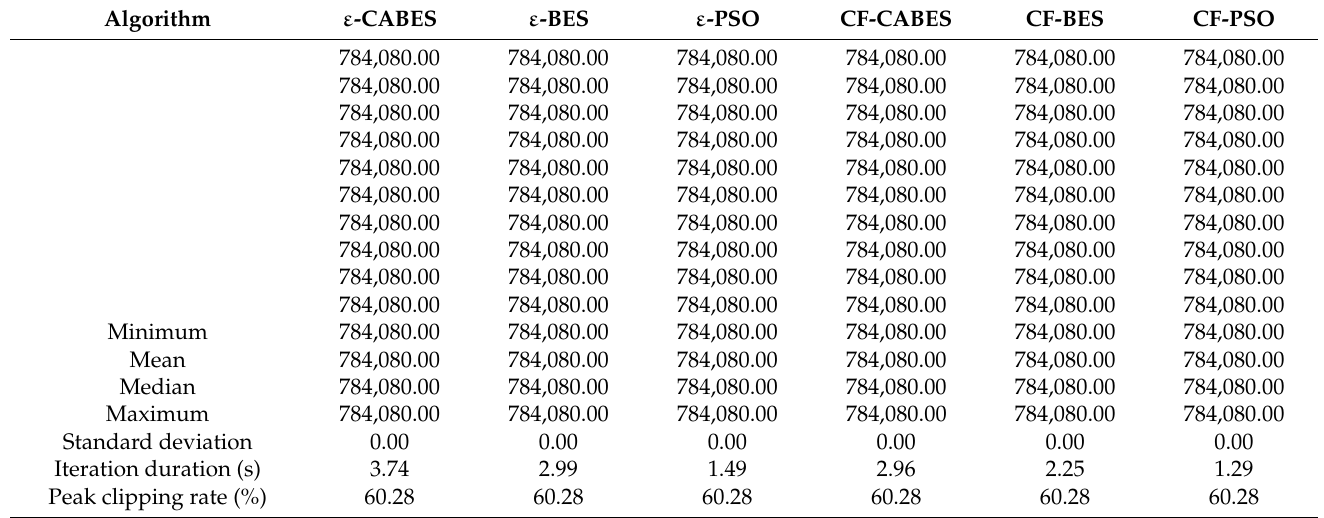
Table 6. Comparison of operation results of different algorithms for Shafan Reservoir.